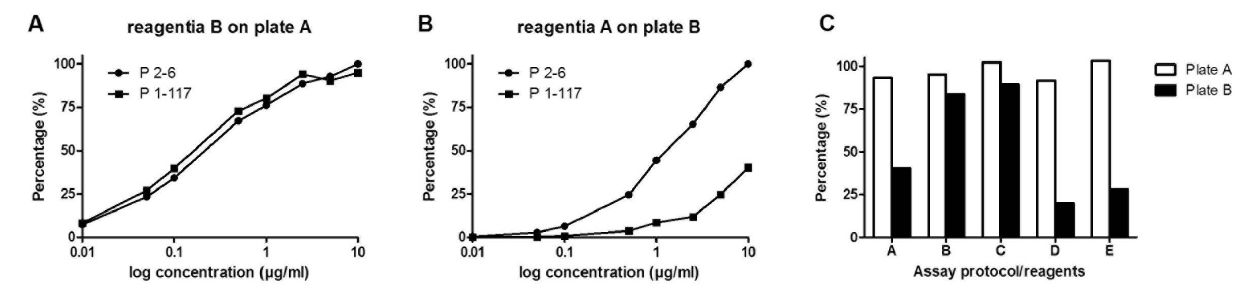
Figure 3. Influence of different assay reagents/protocols on the reactivity of antibodies P1-117 and P2-6 on coated plates of 2 commercial anti- b 2 GPI IgG assays. The reactivity of antibodies P1-117 and P2-6 was tested as explained in Fig. 2 on coated ELISA plates of assay A and B, applying the reagents/protocol of each of the 5 separate assays. Results are expressed as the percentage of the maximum OD value of P2-6. A–B. Graphic representation of results obtained when the protocol and reagents of assay B were applied on a coated plate of assay A (A) and vice versa (B). C. Table showing the reactivity of 10 m g of antibody P1-117 on coated plates of assay A and B using the protocol and reagents of assay A–E.